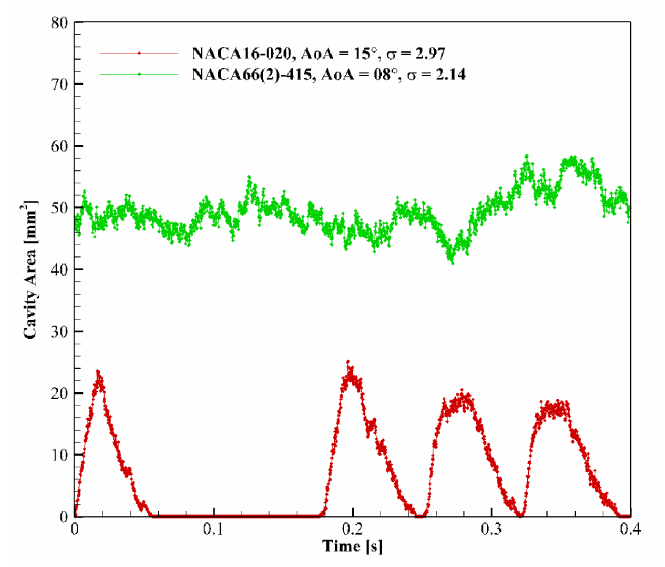
Figure 4. Cavity area variation with time for NACA 16-020 at the instance of cavity inception, α = 15 ◦ , σ = 2.97 and for NACA 66(2)-415 at the instance of cavity inception, α = 8 ◦ , σ =